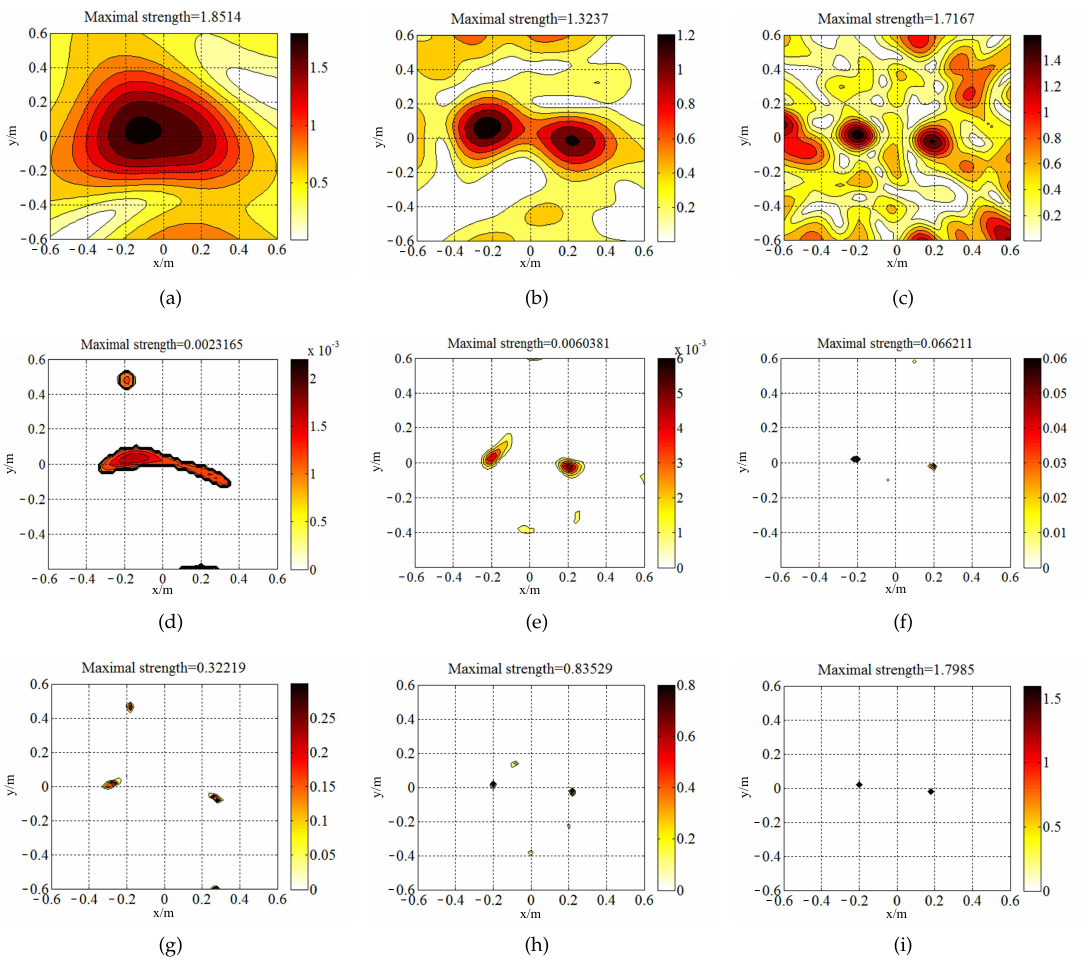
Figure 8. The sources reconstructed for far-field by SOAP, (cid:96) 1 -GIB, and BI-AI (with unit of m 4 /s 2 ): ( a ) SOAP, 500 Hz; ( b ) SOAP, 1500 Hz; ( c ) SOAP, 3000 Hz; ( d ) (cid:96) 1 -GIB, 500 Hz; ( e ) (cid:96) 1 -GIB, 1500 Hz; ( f ) (cid:96) 1 -GIB, 3000 Hz; ( g ) BI-AI, 500 Hz; ( h ) BI-AI, 1500 Hz; ( i ) BI-AI, 3000